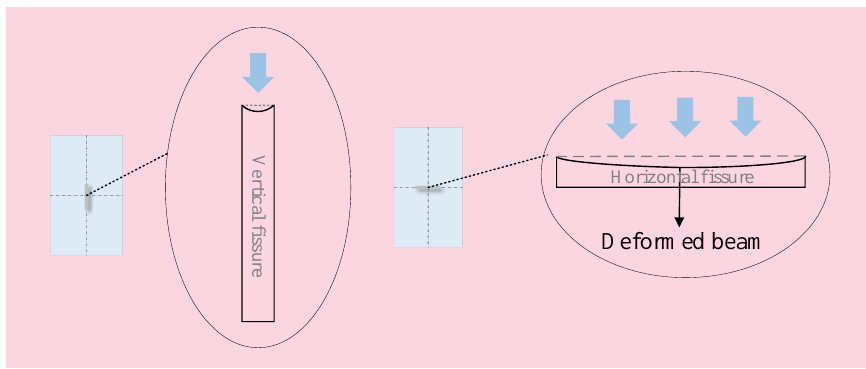
Figure 6. Simplified force analysis of a fissure in a rock sample.